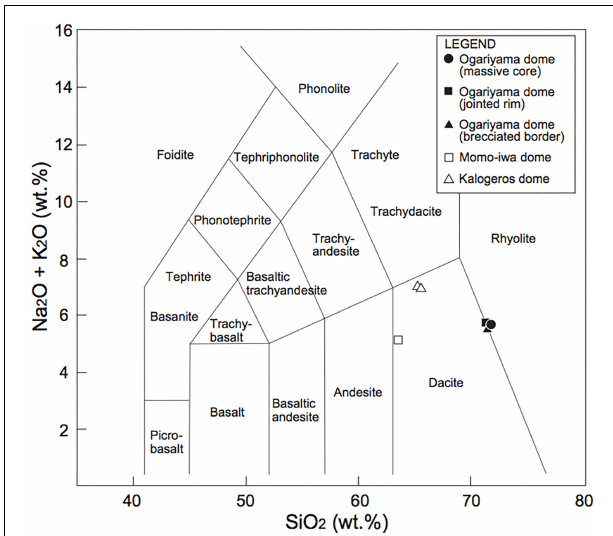
FIGURE 10 | Whole-rock chemical compositions of the Ogariyama dome plotted on the total alkalis versus SiO 2 (TAS) diagram of Le Maitre et al. (1989). Rhyodacites from the massive core (solid circle), jointed rim (solid square), and brecciated border (solid triangle) have identical chemical compositions and plot along the boundary between the dacite and rhyolite fields. Chemical compositions of the Momo-iwa dome in Japan (open square; Goto and McPhie, 1998) and the Kalogeros dome in Greece (open triangles; Stewart and McPhie, 2003) are also shown. All analytical data were recalculated to 100% on an H 2 O (or loss on ignition) free basis.